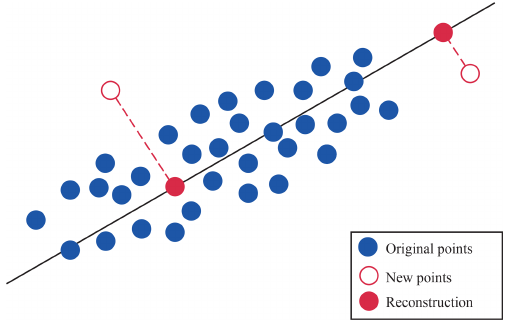
Figure 7. Anomaly detection employing PCA